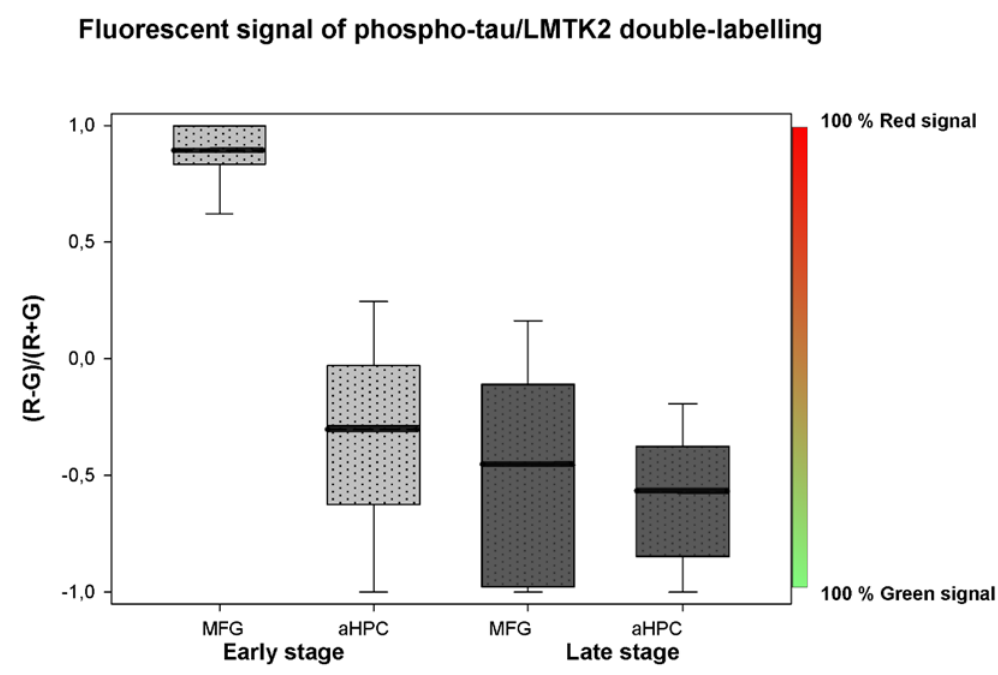
Figure 5. Phospho-tau and lemur tyrosine kinase 2 (LMTK2) double-labelling fluorescent immunohistochemistry signals of the middle frontal gyrus (MFG) and anterior hippocampus (aHPC) in early (dotted light gray boxes) and late (dotted dark gray boxes) neuropathological Braak tau stages are quantified. Boxes represent the interquartile range of the fluorescence signal of phospho-tau (green) and LMTK2 (red) on a unified scale ( − 1 to + 1) with mean levels indicated by black lines. ( − 1 corresponds to 100% phospho-tau signal compared to 0% LMTK2; + 1 means 100% LMTK2 signal and 0% phospho-tau.). Table 2. Statistical analysis of lemur tyrosine kinase 2 (LMTK2) (red) / phospho-tau (green) fluorescent signal correlation in the middle frontal gyrus (MFG) and anterior hippocampus (aHPC) in early